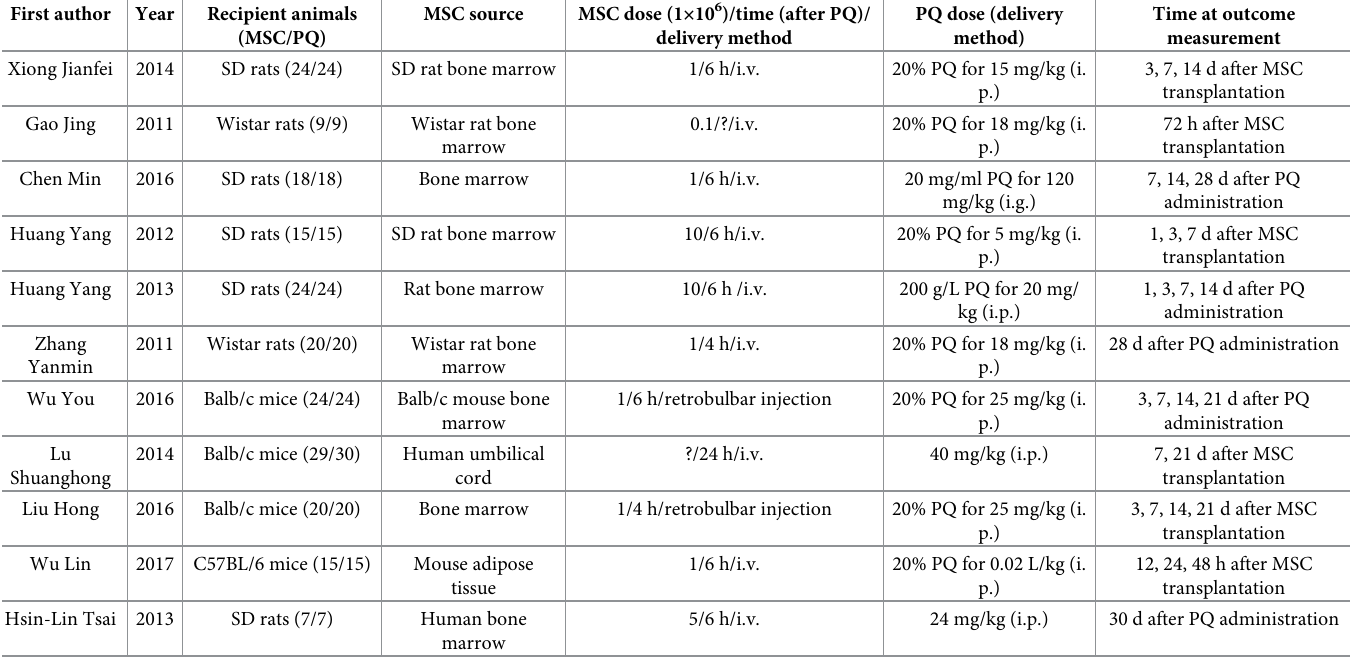
Table 1. Characteristics of the included